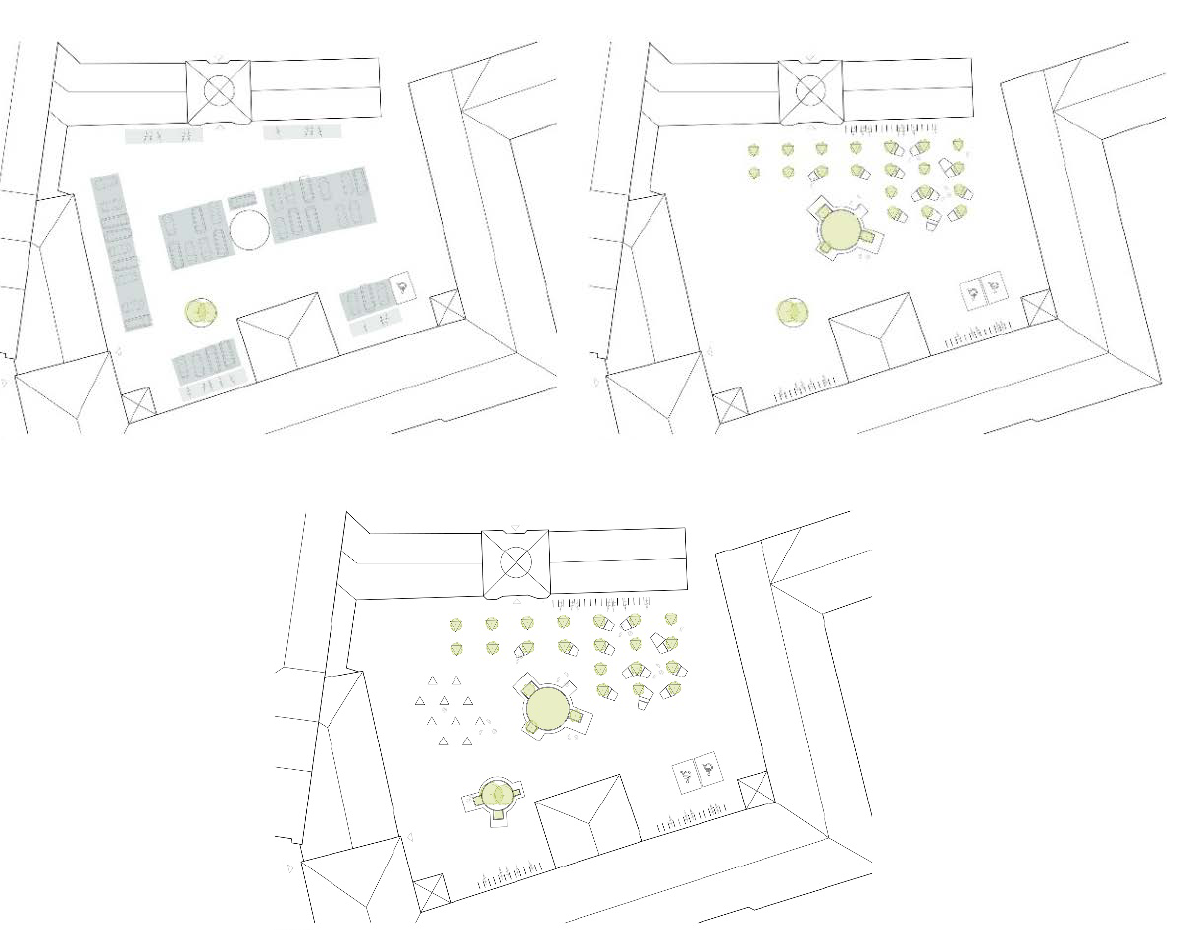
Figure 11. Transformation process of the Courtyard City Hall by Atelier Starzak Strebicki in 2015. Top left: Phase 0: 2014—existing situation—parking in the courtyard; top right: Phase 1: 2015–2016—public accessible courtyard with street furniture; bottom left: Phase 2: 2016–2019—publicly accessible courtyard with street furniture and new round bench and exhibition system.